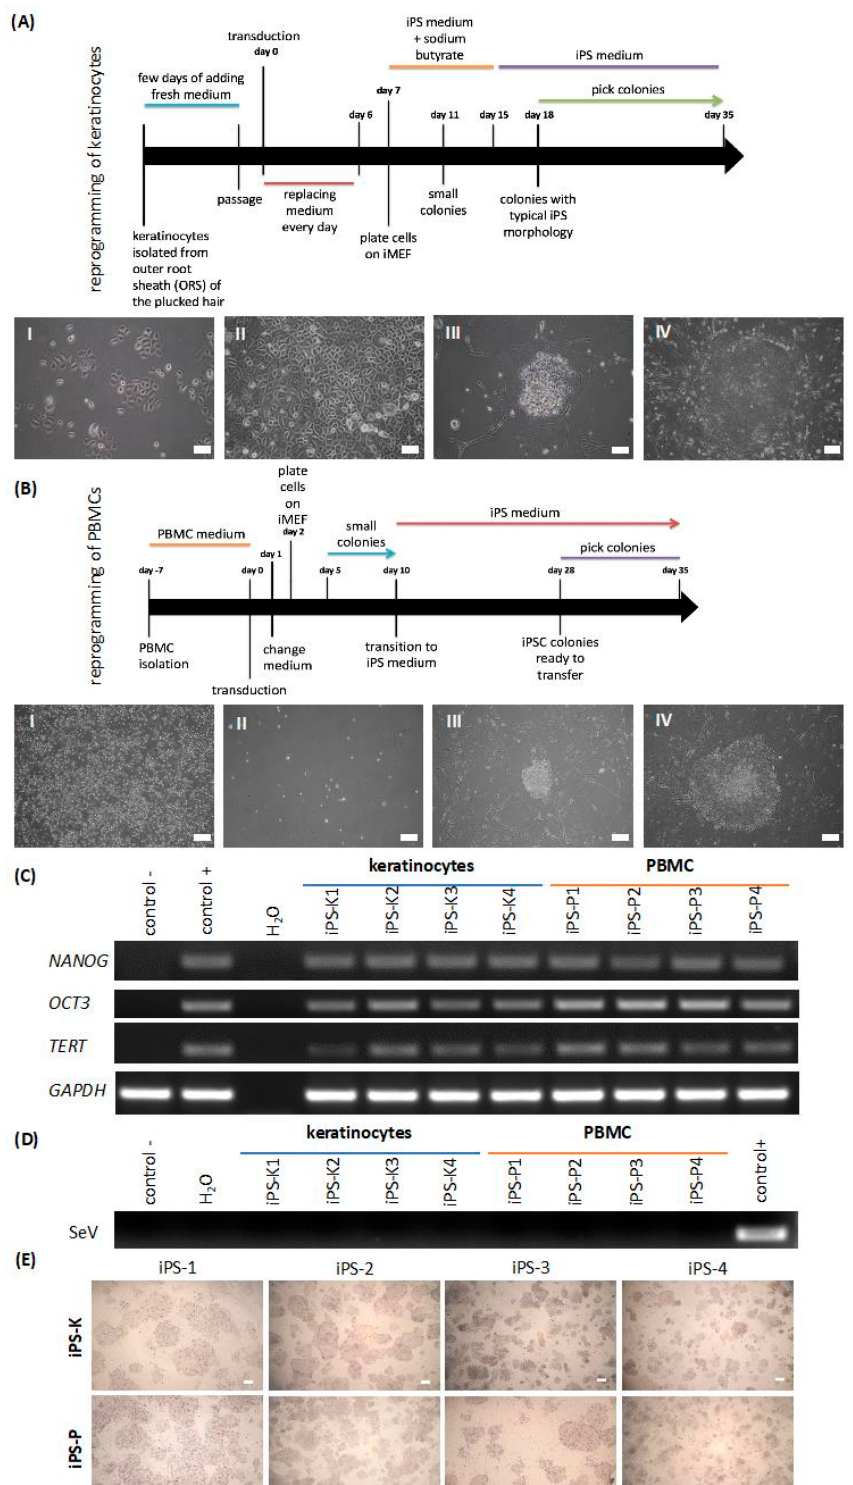
Figure 1. Reprogramming of keratinocytes and peripheral blood mononuclear cells (PBMCs) to induced pluripotent stem cells (iPSCs) with Sendai viral vector. Characterization involved 4 clones of each origin of iPS cells. ( A ) Scheme presenting generation of iPS cells from plucked hair keratinocytes. ( AI ) Representative image of the cells four days after transduction. ( AII ) Morphology of the tightly-packed cells, which is characteristic of the early stage of reprogramming. ( AIII ) Formation of the first colonies on day 14 after transduction. ( AIV ) A big and tightly packed colony, which is ready to be